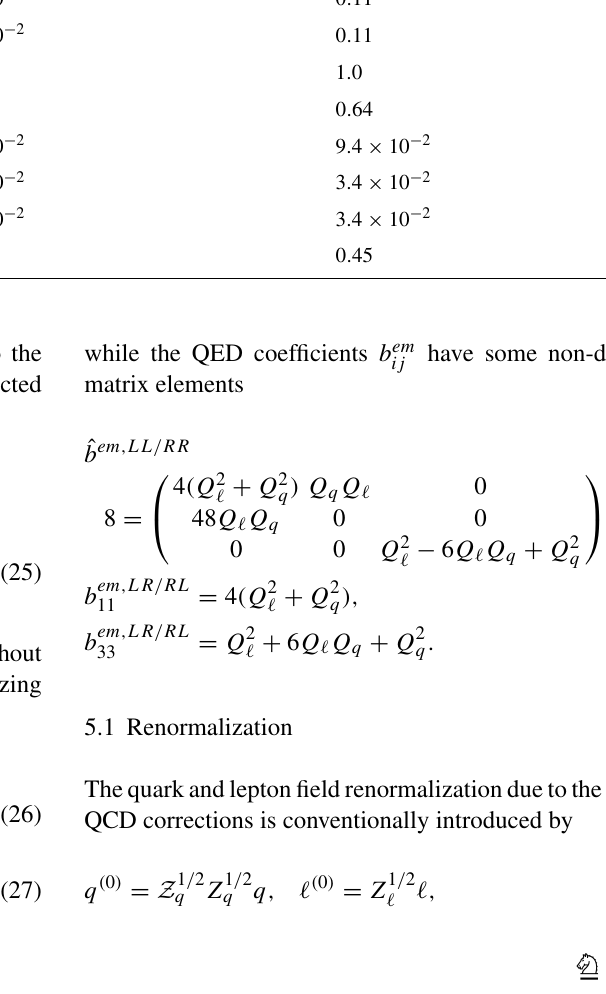
(cid:2) 1 (cid:2) 2 . See the caption of Table 2 for